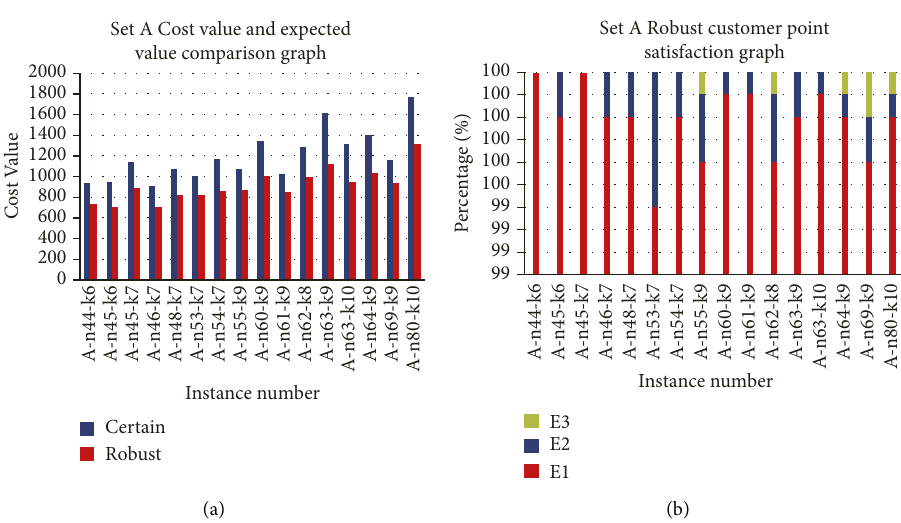
Figure 3: Set A results charts. (a) Set A cost and expected value comparison graph. (b) Set A robust customer point satisfaction